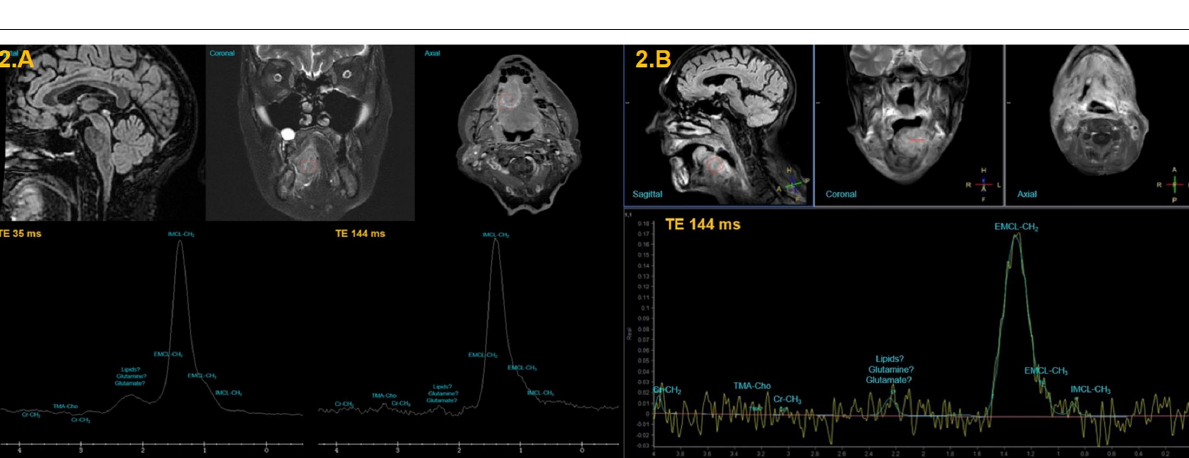
3D T1-weighted spin-echo with contrast enhancement. 1 H- MRS acquisitions consisted of a single-voxel Point RESolved Spectroscopy (PRESS) sequence with two echo times (TE = 35